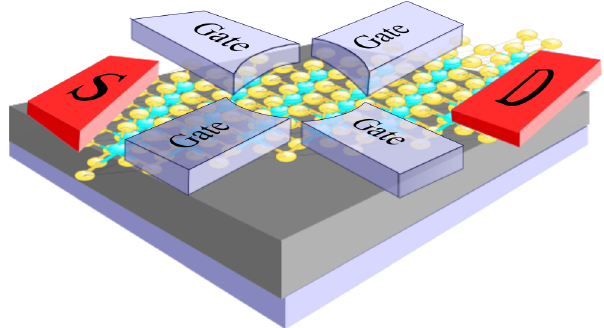
FIG. 2 Spin-resolved band structure of MoS 2 from DFT calculations. The qualitative features of the band structure are the same for all TMDCs. An enlargement of the region in the black frame is shown in the upper panel of Fig.